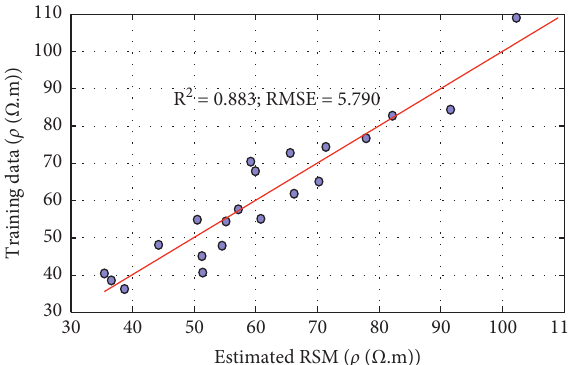
Figure 15: RSM electric resistance response error estimate.